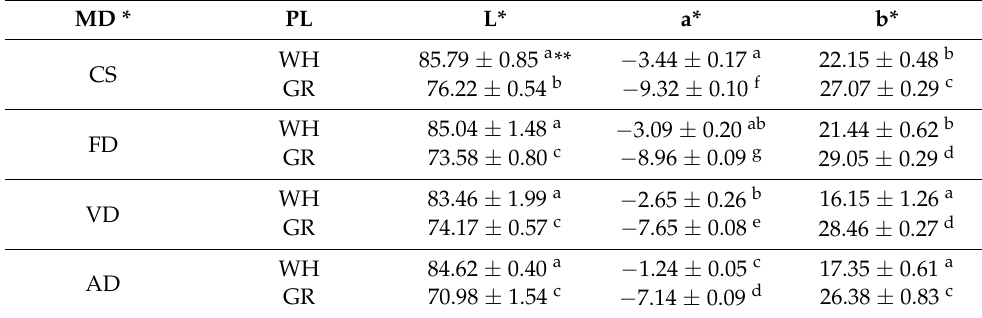
Table 3. Effect of the drying method on the color parameters of leek.